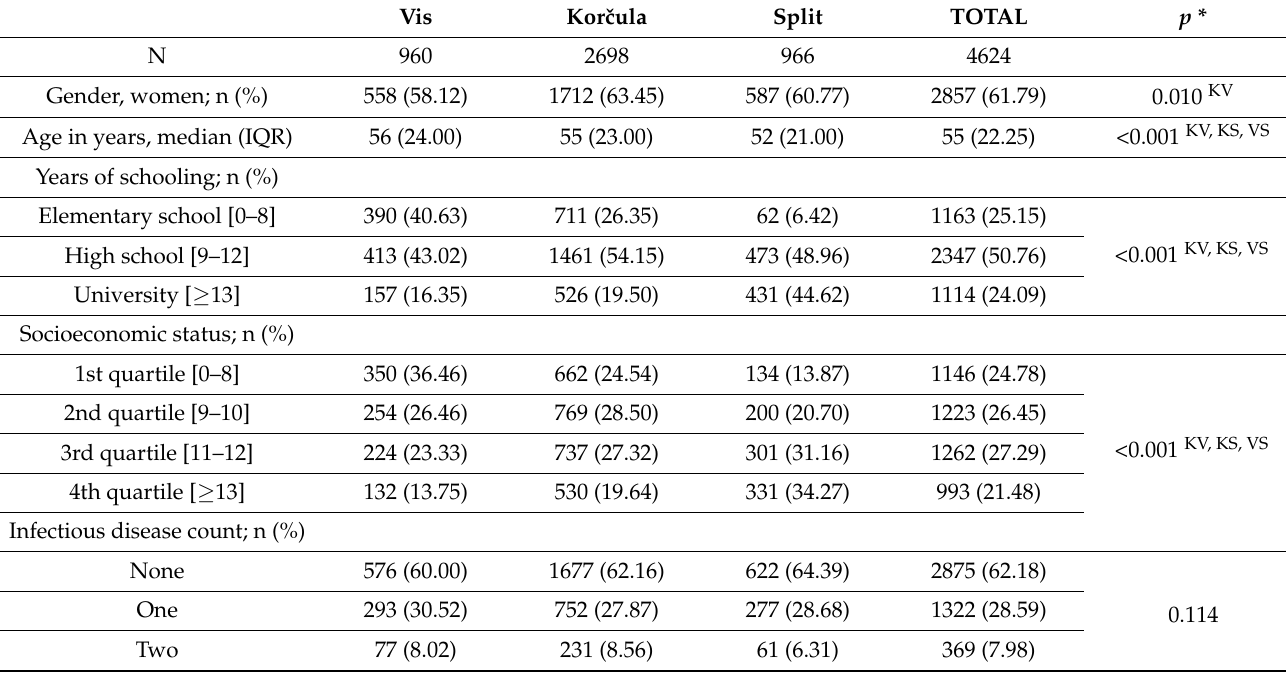
Table 1. Demographic and phenotypic characteristics of study